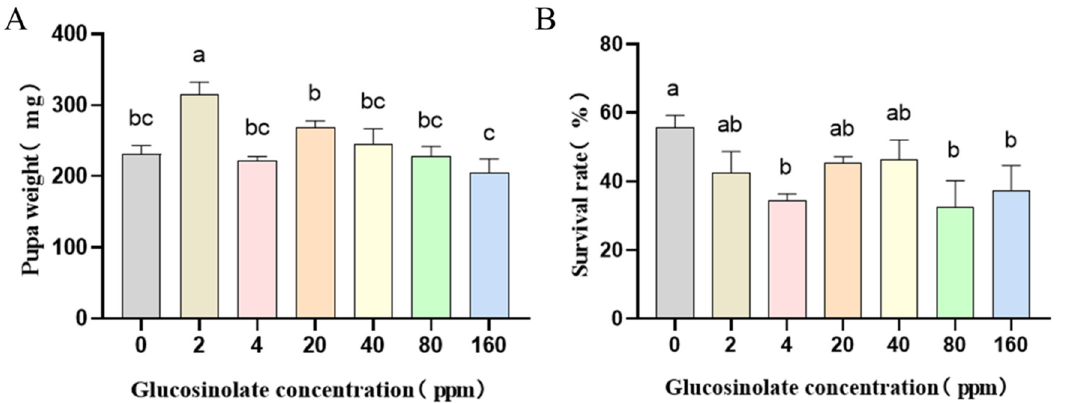
Figure 3. The weight and survival rate of H. armigera pupae under different concentrations of glucosinolate: ( A ) Weight of H. armigera pupae; ( B ) Survival rate of H. armigera pupae; Error bars indicate the standard error of the mean (SE) ( n = 100). Lowercase letters indicate significant difference at p < 0.05 (One-way ANOVA).